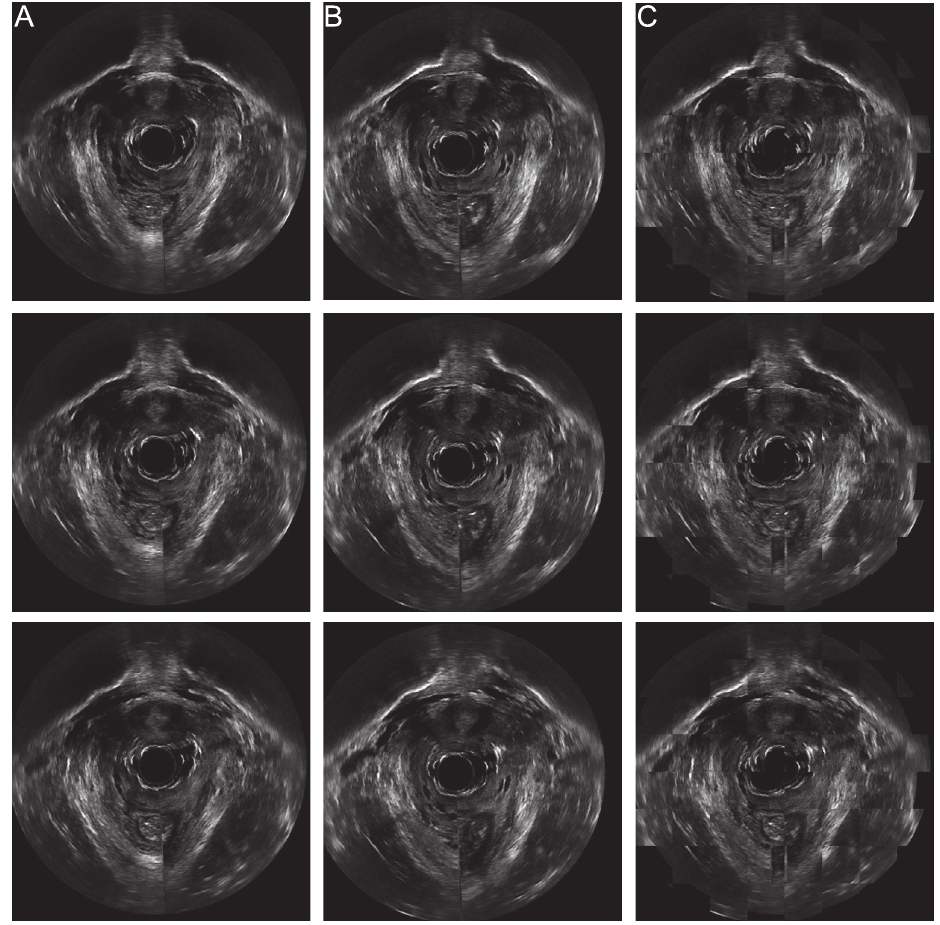
Fig 7. Checkerboard validation. (A) A sequence of fixed images in coronal view. (B) Moving images at the same imaging planes after 3D registration. (C) Checkerboard images of the two images on the corresponding rows, which show structure continuity and demonstrate effectiveness of M3VR.